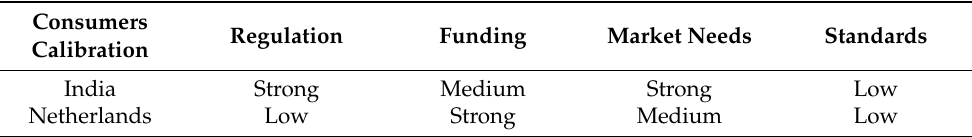
Table 2. The main smart grid implementation challenges facing both India and the Netherlands arranged by strong to low